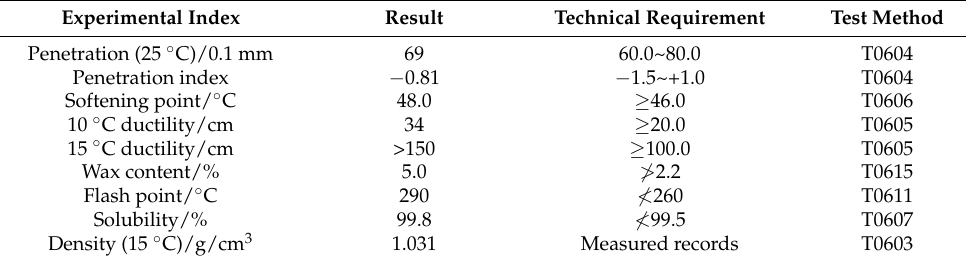
Table 1. Technical index of Qilu 70-A Base Asphalt. Experimental